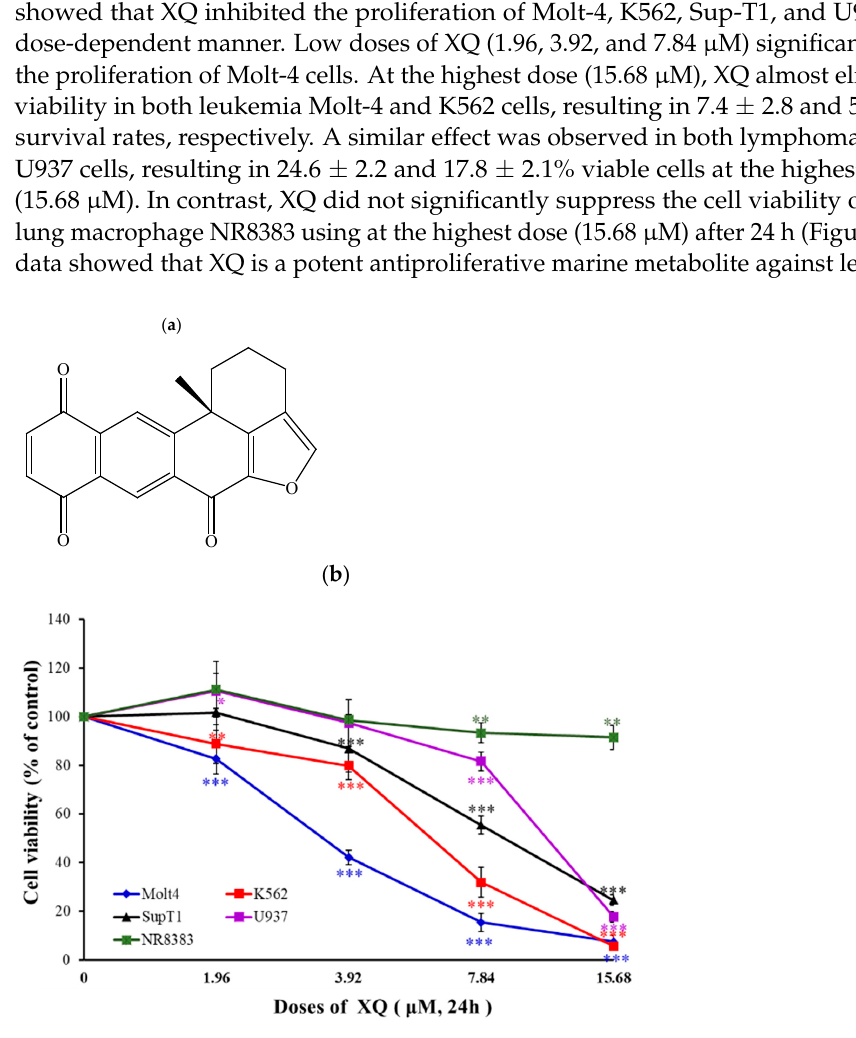
Figure 1. Effect of xestoquinone (XQ) on cellular viability in the in vitro cellular model. ( a ) The structure of the marine polycyclic quinone metabolite XQ isolated from the ethyl acetate (EtOAc) extract of Petrosia sp. sponge. ( b ) Human leukemia (Molt-4 and K562) cells and lymphoma (Sup-T1 and U937) cells as well as normal rat NR8383 macrophages were treated with XQ at different doses for 24 h. The viability was determined by the MTT assay. The results are presented as means ± SD of three independent experiments; * p < 0.05, ** p < 0.01, and *** p <